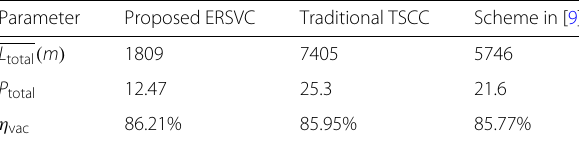
Table 7 Comparison of performance for proposed ERSVC